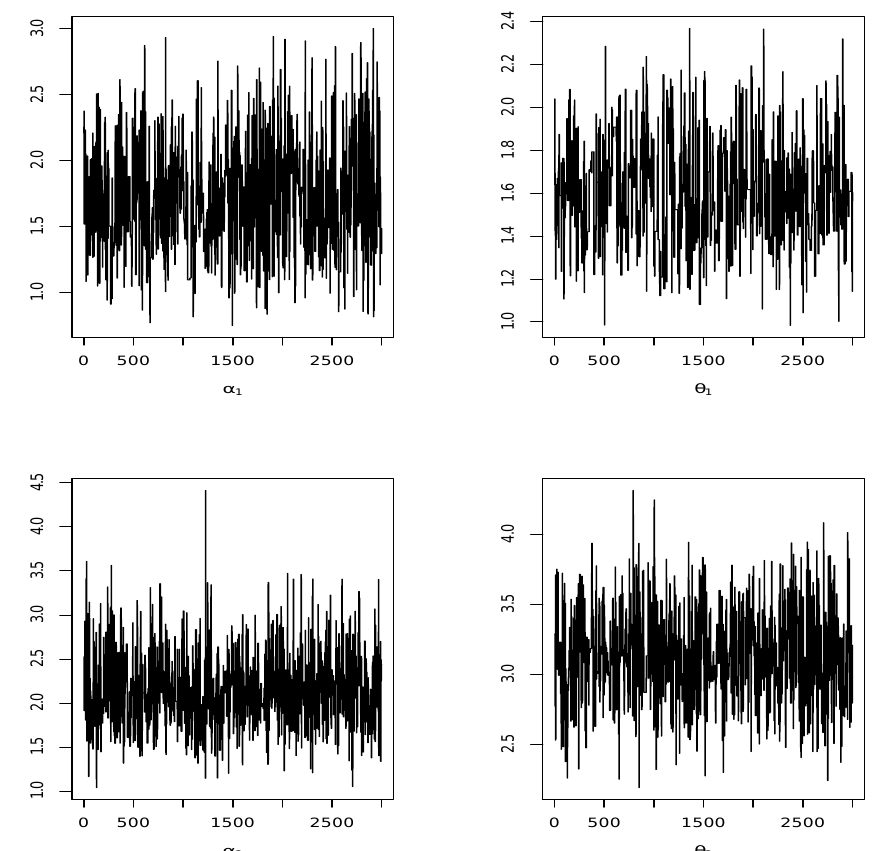
Figure 2. Trace plots of distribution parameters ( α 1 , θ 1 , α 2 , θ 2 ) .